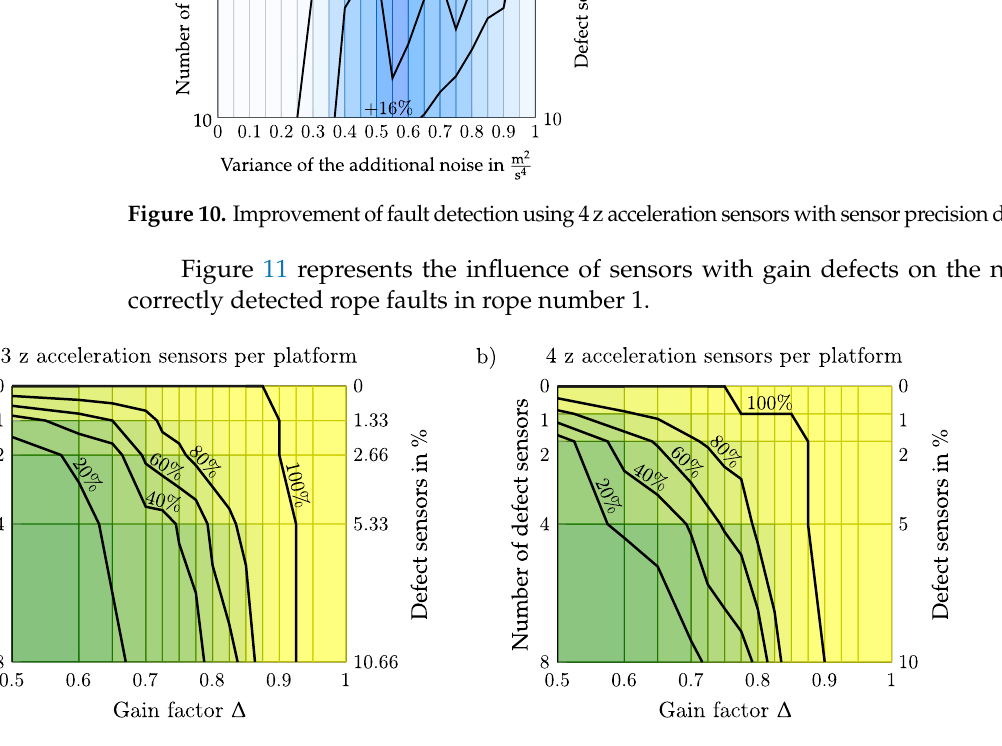
Figure 11. Impact of sensor gain defects on the percentage of correct detected rope faults by the EKF rope fault estimation for a rope fault in rope number 1. ( a ) 3z acceleration sensors and ( b ) 4z acceleration sensors per platform are